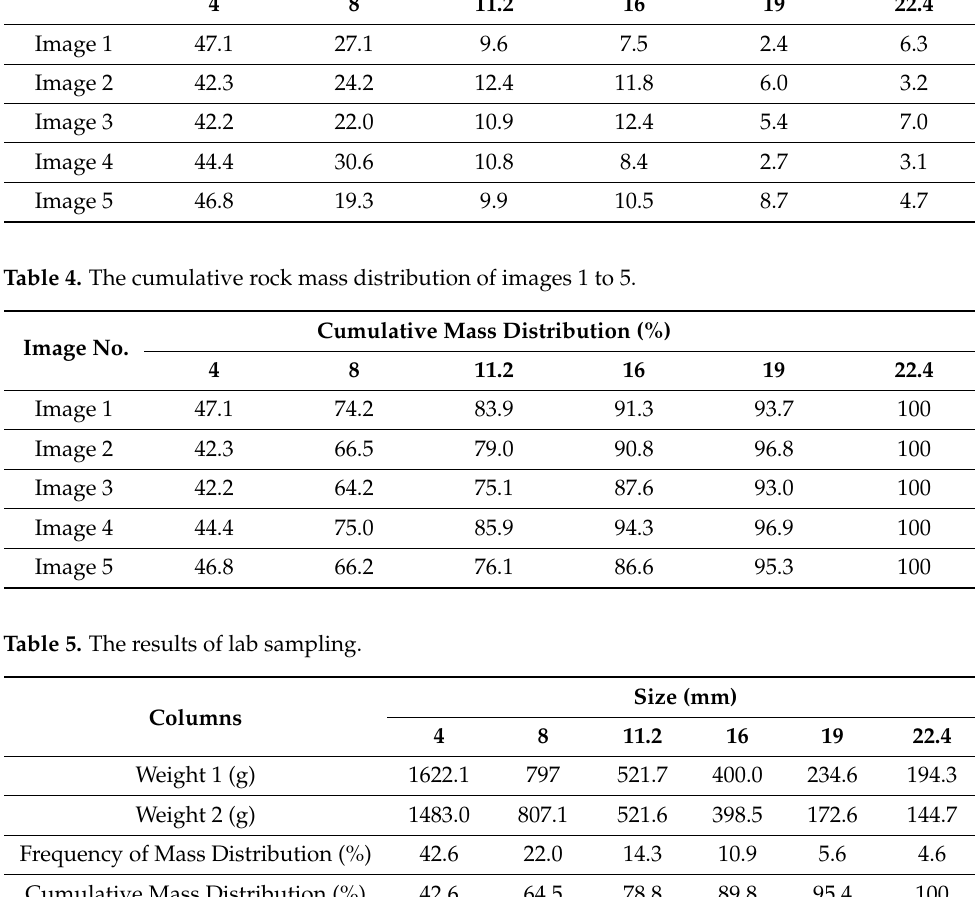
Figure 11. The results of the pixel area distribution compared with manual labels of image 1: ( a ) frequency of area distribution; ( b ) cumulative area distribution. Table 3. The frequency of rock mass distribution of images 1 to 5. Image No.